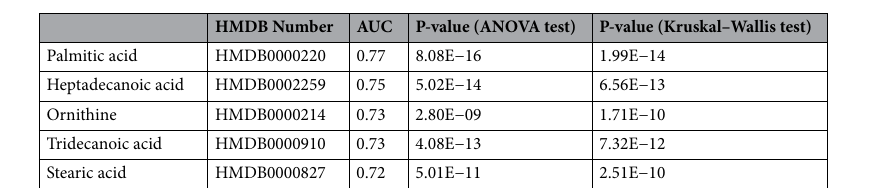
Table 4. Most significant biomarkers for discriminating healthy controls, early-stage patients, and advanced- stage lung cancer